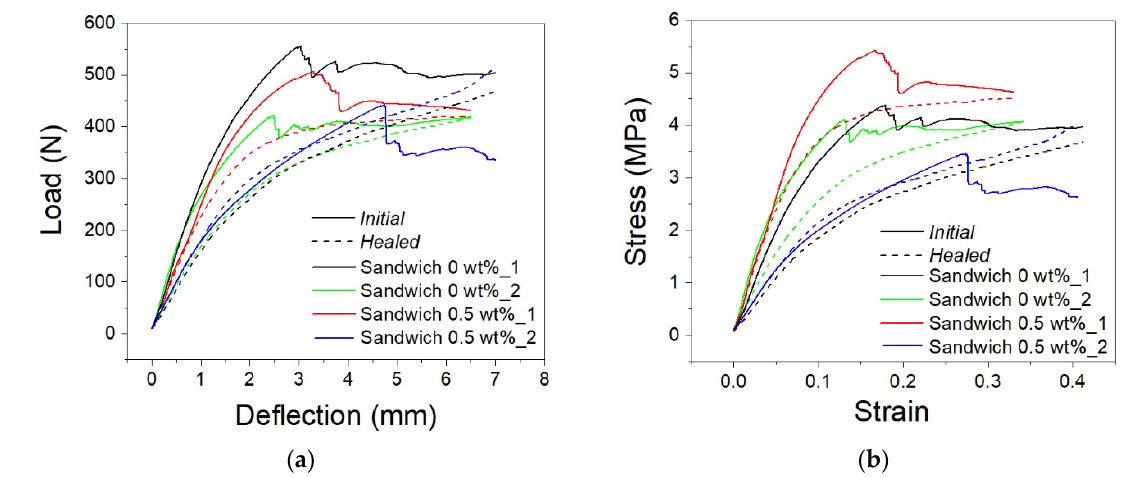
Figure 11. Load–displacement ( a ) and stress–strain ( b ) curves of SM sandwiches at initial state and after recovery.